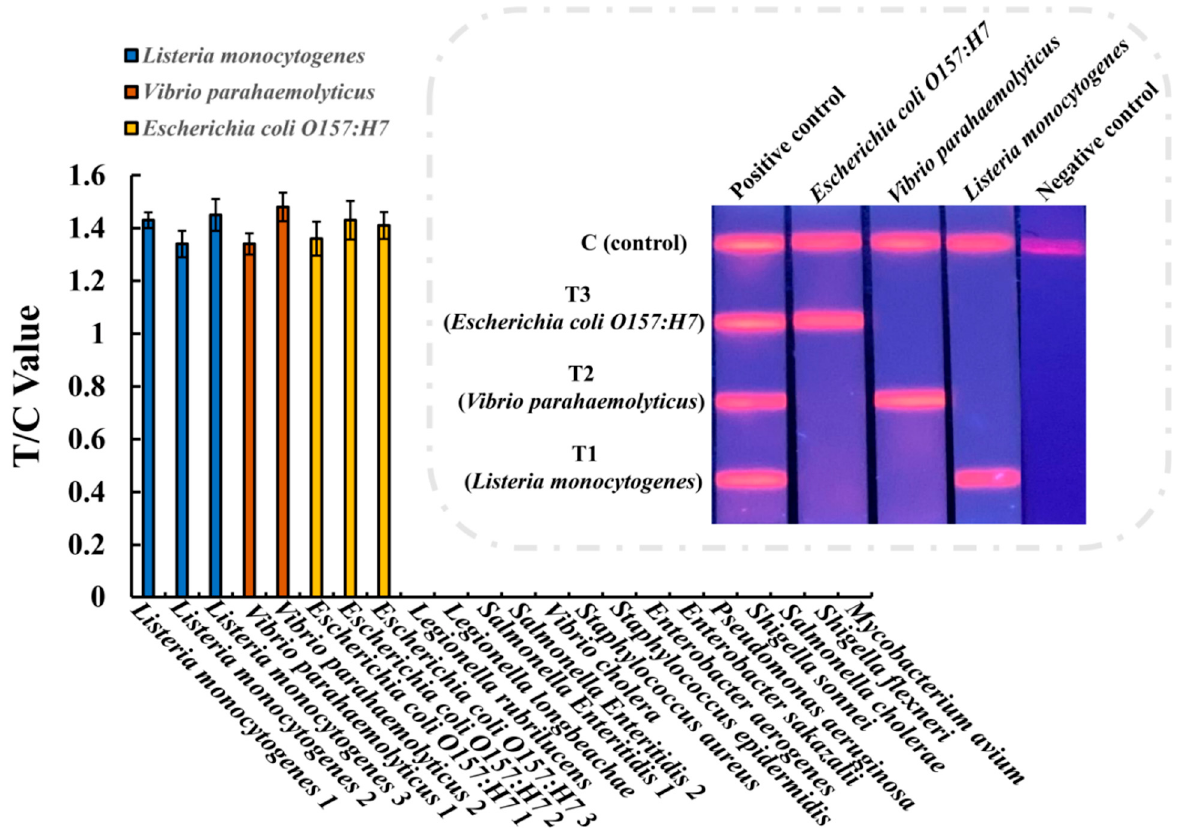
Figure 4. Specificity testing of EuNP-based LFIA–RPA. Specific evaluation results from 22 bacterial strains.